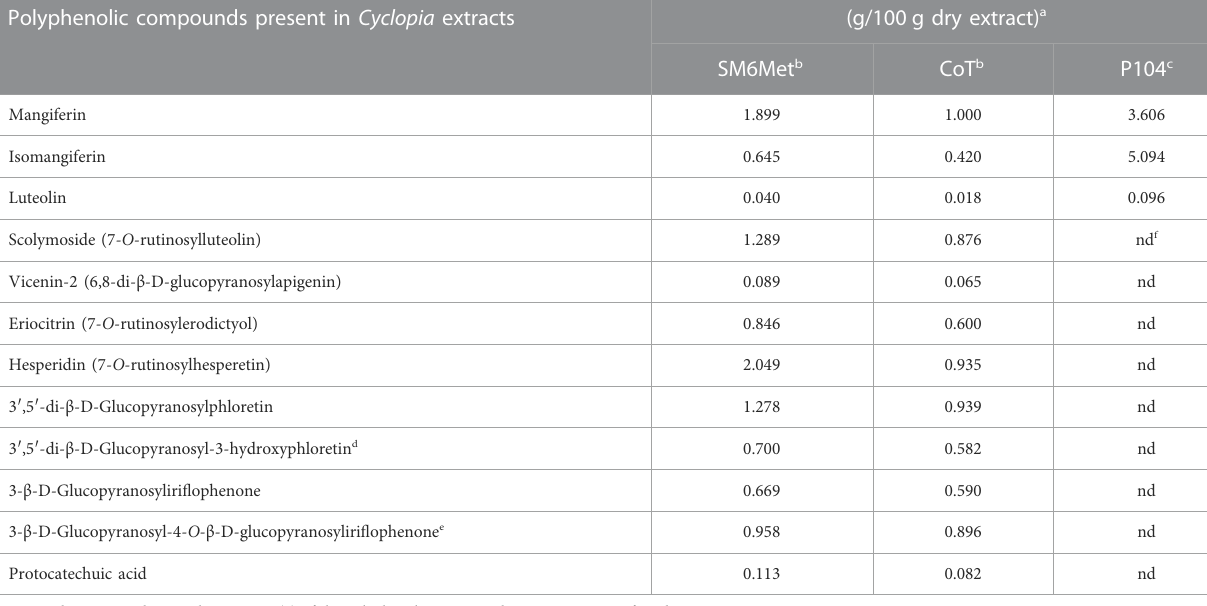
TABLE 1 Major polyphenols present in previously prepared Cyclopia extracts as determined by HPLC. Polyphenolic compounds present in Cyclopia